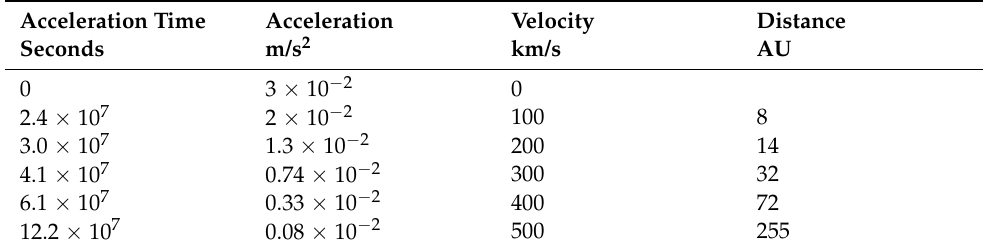
Table 1. Kinematics of 10 7 kg electric sail starship. Acceleration begins at 1 AU from circular solar orbit; R f 2 ρ = 7.84 × 10 19